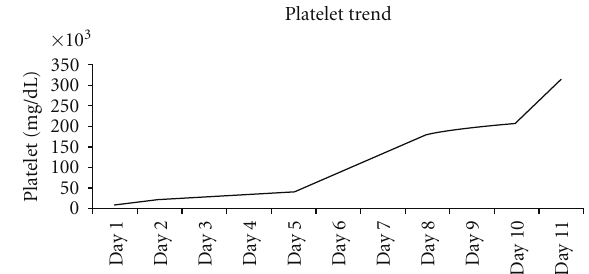
Figure 2: Patient’s platelet trend during hospital stay after discon- tinuation of moxifloxacin and initiation of